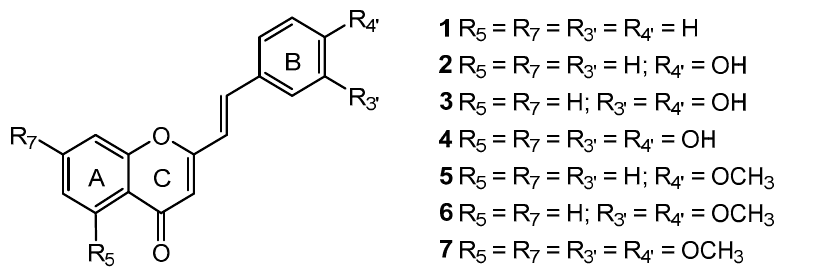
Figure 1. Chemical structure of the tested Figure 43. Chemical structure of the tested 2-SC.